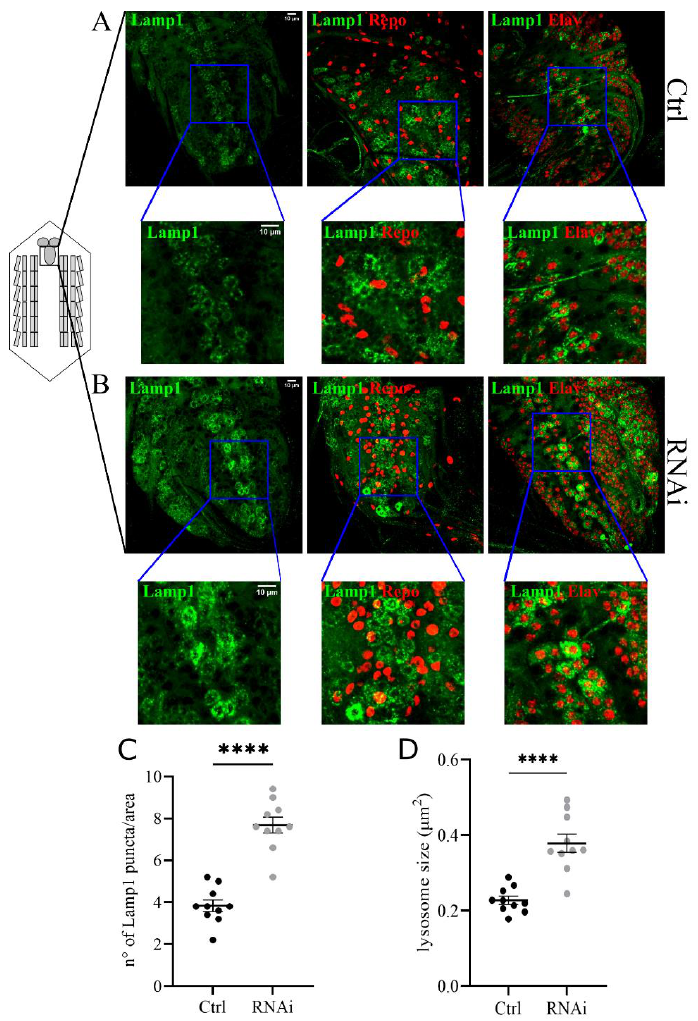
Figure 4. Downregulation of D-idua leads to the accumulation of enlarged lysosomes in the central nerve cord. Representative confocal images of central nerve cords expressing the marker GFP-Lamp1 in ( A ) control and ( B ) RNAi III instar larvae and the relative quantification of the ( C ) number and ( D ) size of lysosomes. n = 10 larvae/group. All data are expressed as means ± SEM. Asterisks indicate a statistically significant difference with respect to control (two-tailed Student’s t -test **** p < 0.0001). Genotypes of samples: Ctrl = Tubulin-Gal4; UAS GFP-Lamp1/+; RNAi = Tubulin-Gal4; UAS GFP-Lamp1/UAS D-idua RNAi3 . The size and number of lysosomes were automatically calculated with the software ImageJ in a ROI (area) of 150 µm 2 , as specified in the materials and methods section.